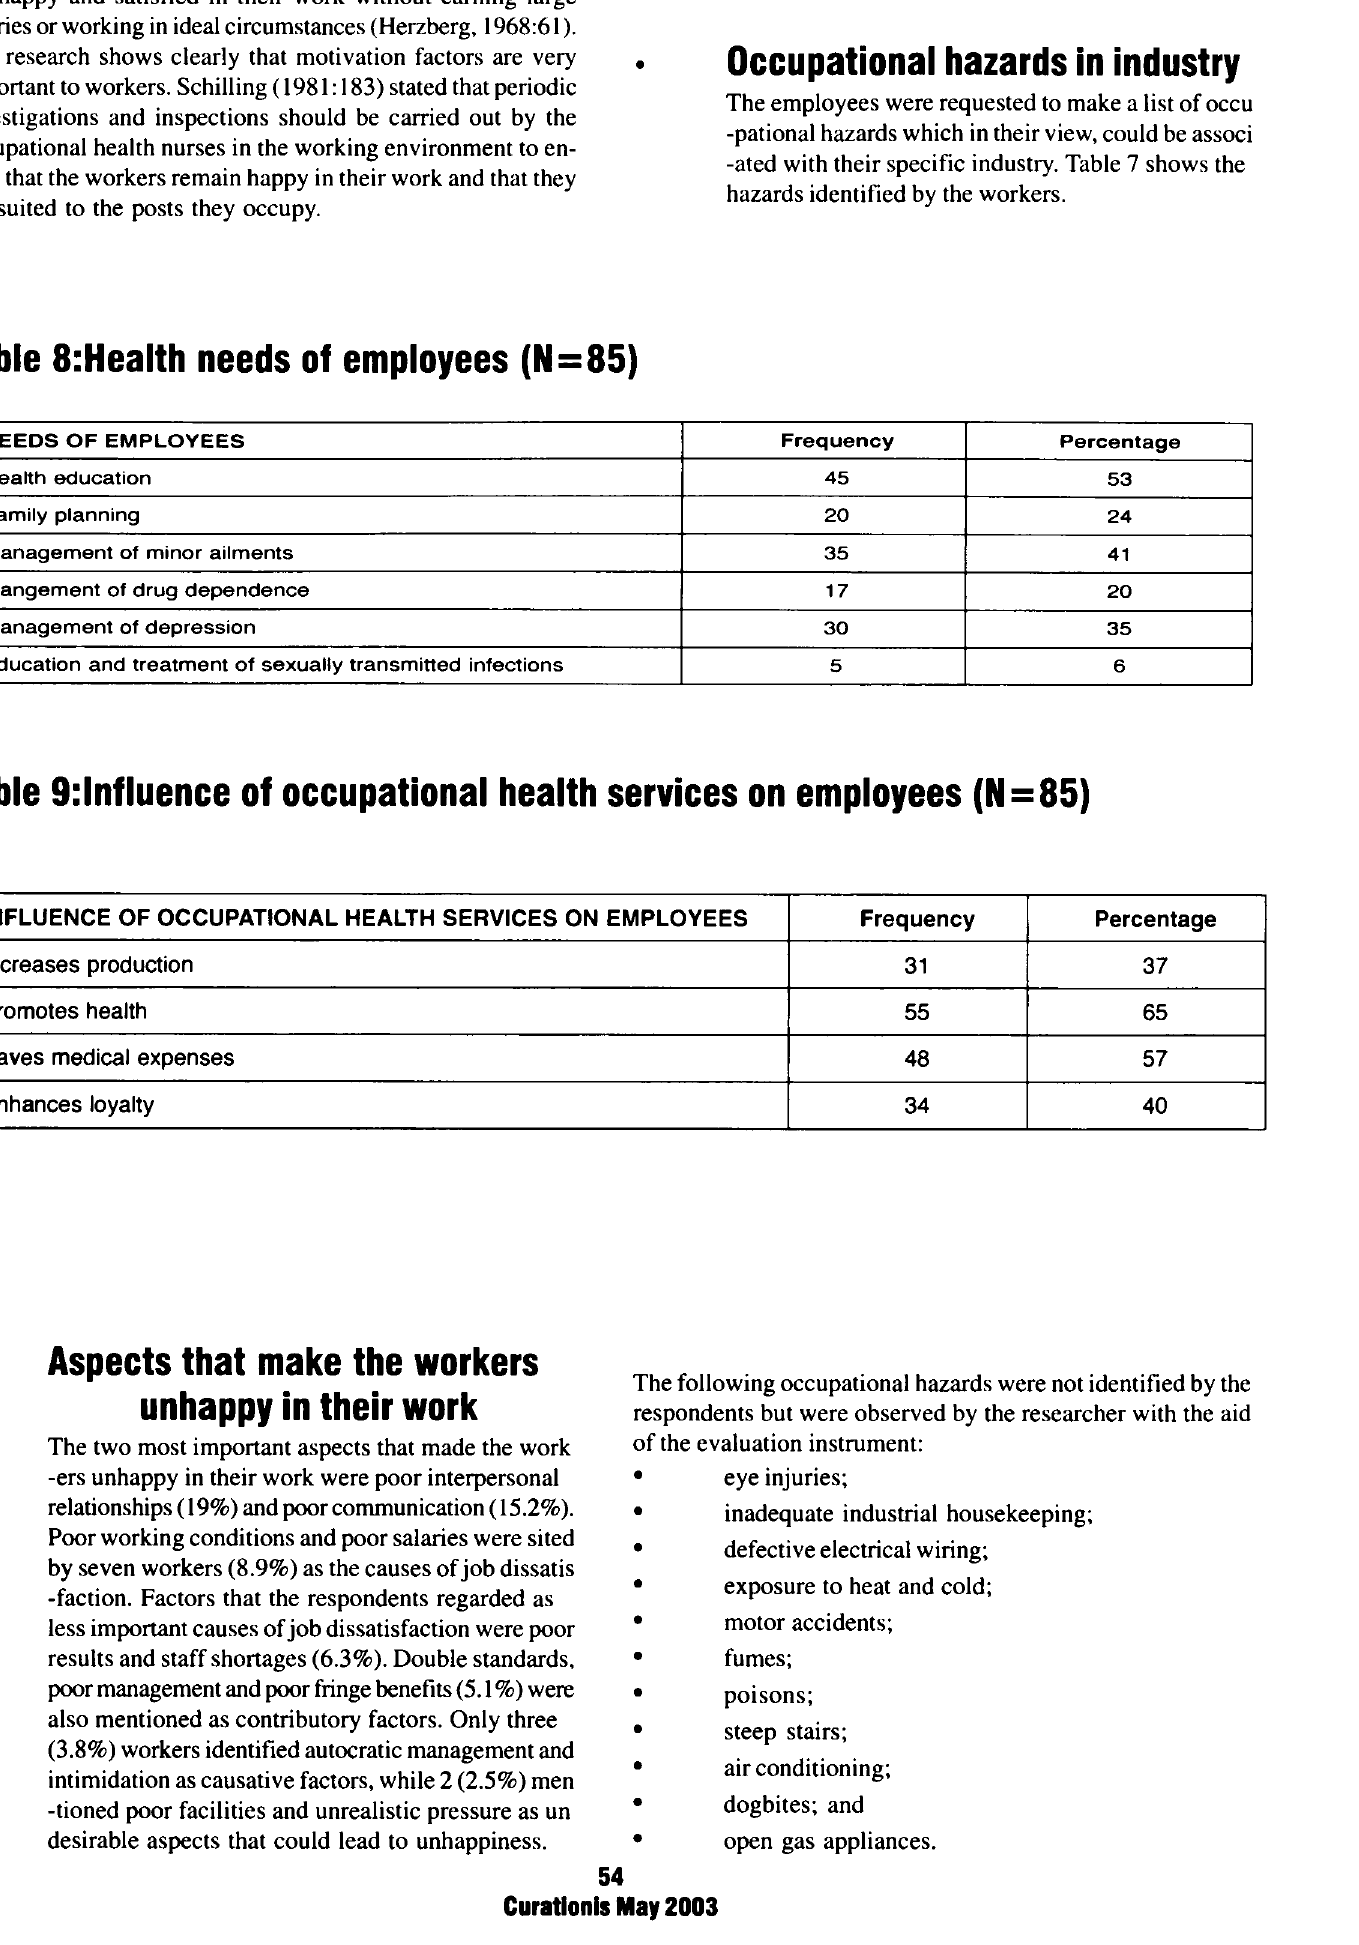
Table 9;lnfluence of occupational health services on employees (N=85) INFLUENCE OF OCCUPATIONAL HEALTH SERVICES ON